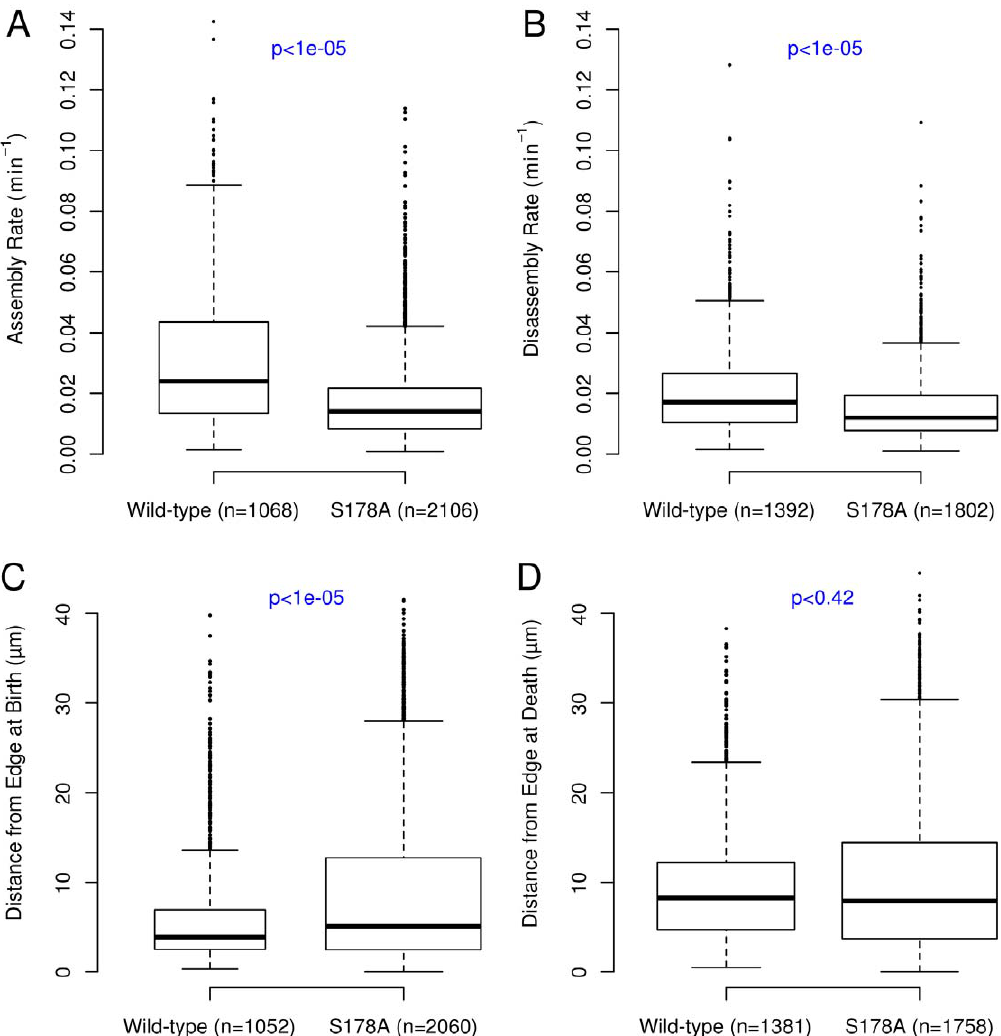
Figure 7. The S178A mutation in Paxillin alters adhesion assembly and disassembly. (A and B) The rate of adhesion assembly and disassembly are significantly decreased by the S178A mutation. The S178A median FA assembly rate is decreased by 42% compared to the wild-type cells, while the median disassembly rate is decreased by 36%. (C and D) The S178A mutation shifts the median adhesion birth location away from the cell edge, but has no effect on the location of cell death. The S178A median adhesion birth position is 31% greater than wild-type median birth position. The median position at adhesion death is decreased by 4% between the S178A and wild-type cells. P-values were calculated in the same manner as in Figure